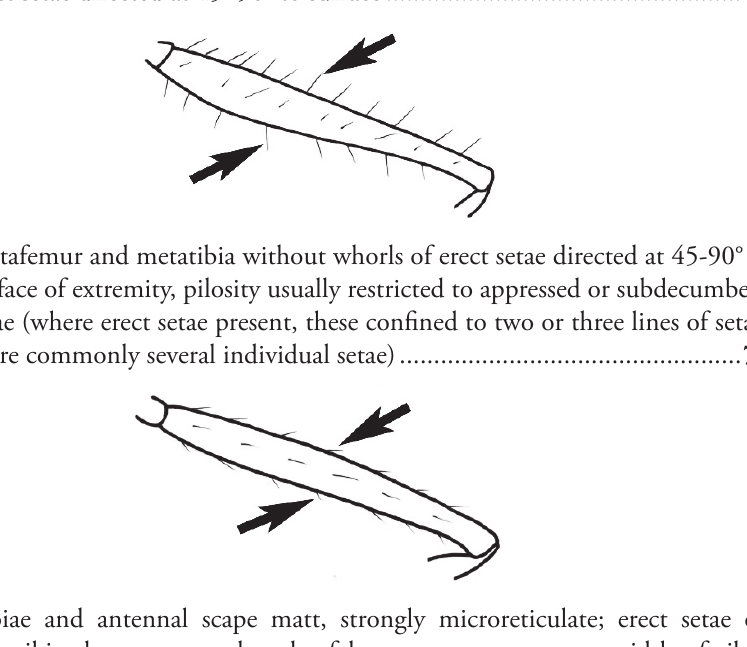
At least lower metafemur (shown here) and all of metatibia with whorls of erect setae directed at 45–90° to surface .................................................... 66